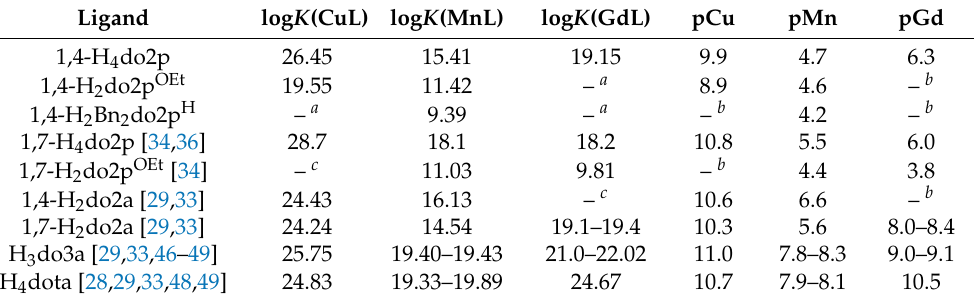
Table 3. Comparison of stability constants of Cu(II), Mn(II), and Gd(III) complexes with 1,4-H 4 do2p and related ligands, and calculated concentrations of the free metal ion (pM = − log[M]) for C L = C M = 0.001 M and pH = 7.4.